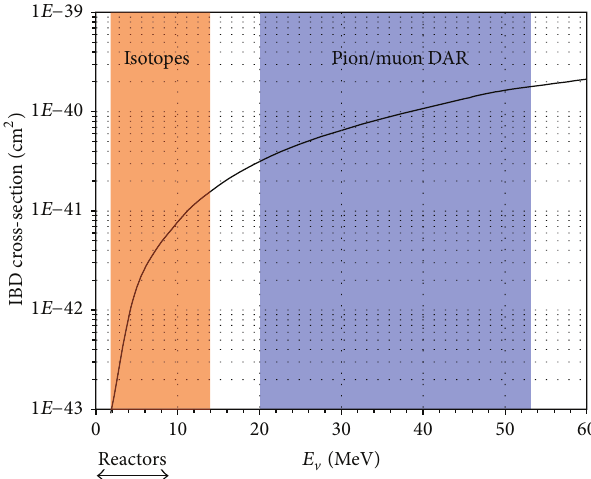
Figure 4: Overlay of high flux regions on the IBD